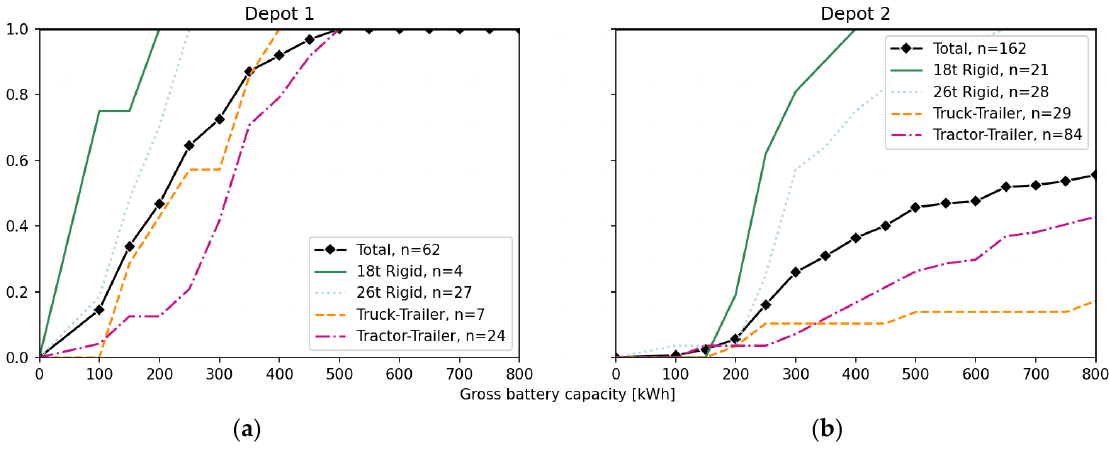
Figure 5. BET feasibility per truck class as CDF over gross battery capacity; ( a ) Depot1; ( b ) Depot2— own